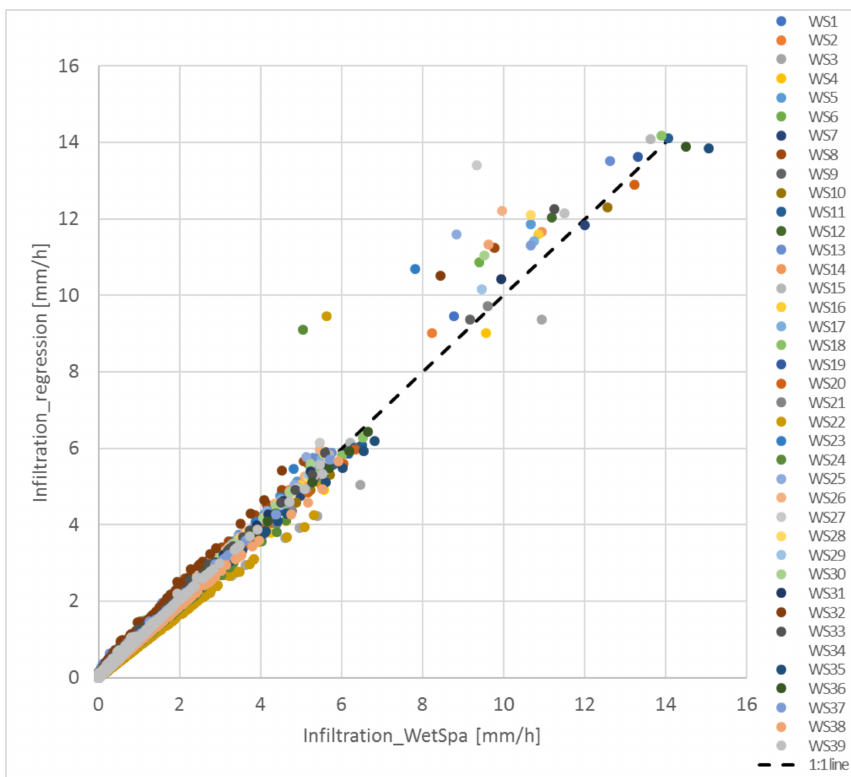
Figure 6. Infiltration regression for the 39 sub-catchments (WS) of the